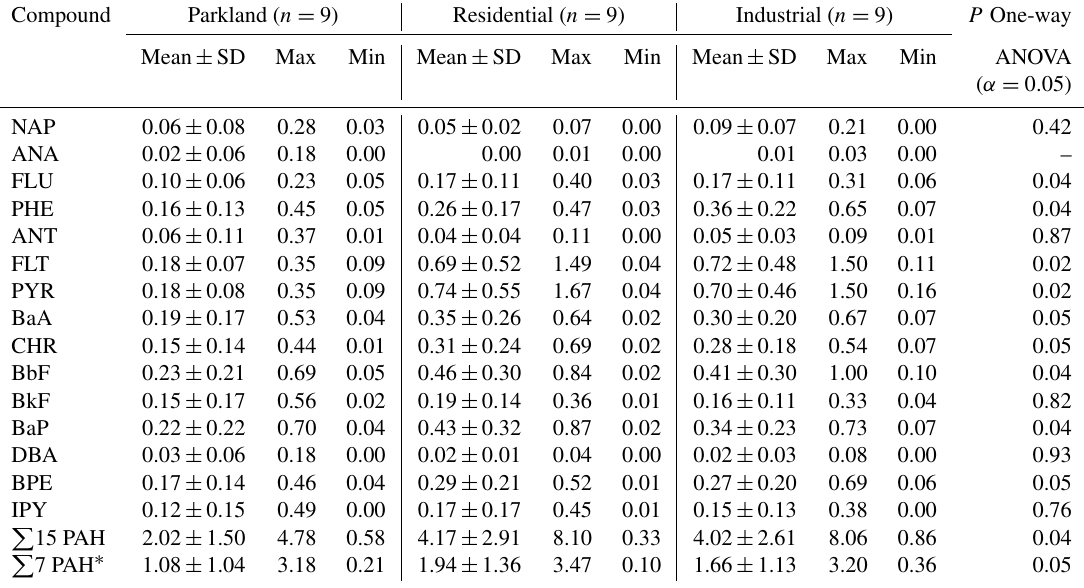
Table 3. Mean PAH concentrations in soils of St. Petersburg (mgkg − 1 ) .